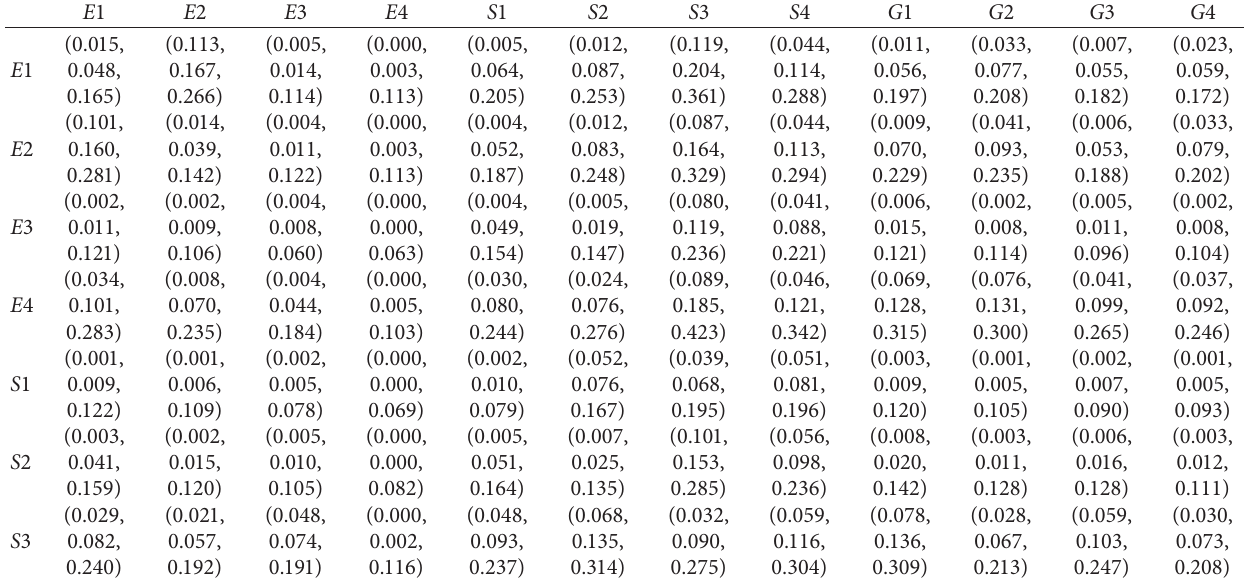
Table 11: Total relationship matrix of sustainability criteria in Z-number